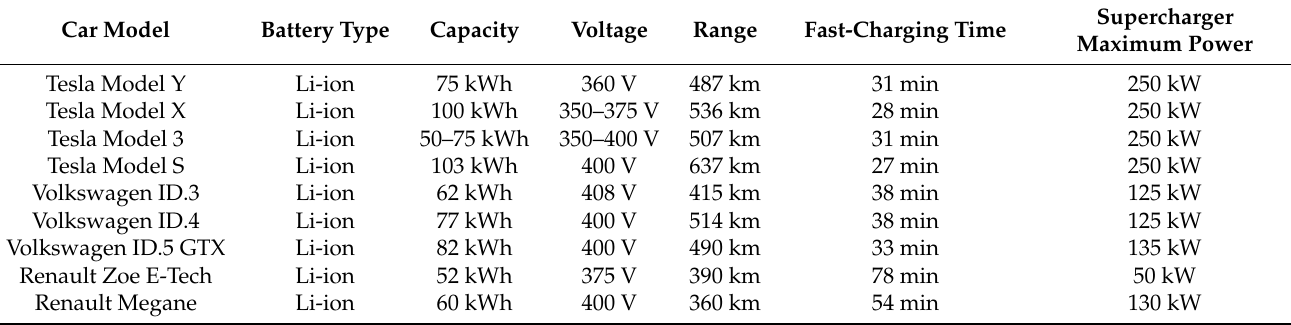
Table 3. Battery characteristics for some of EV